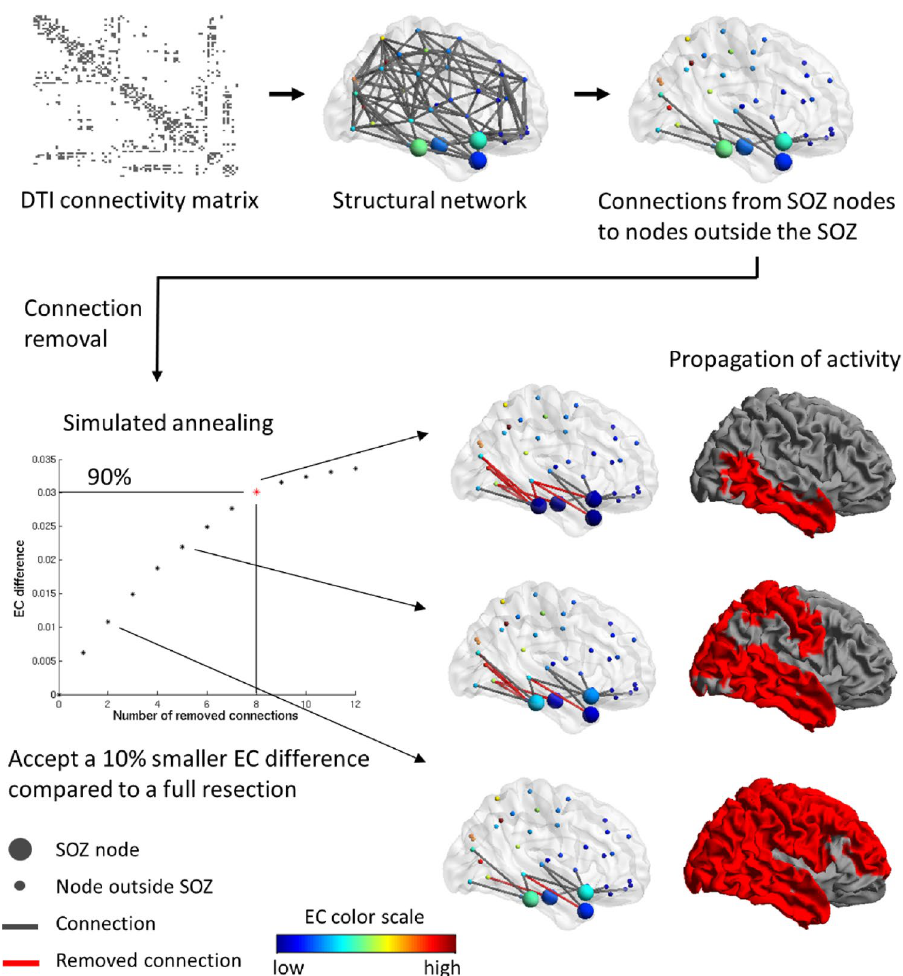
Figure 2. Workflow of selecting the connections to remove for each patient. The patient’s DTI connectivity matrix of white matter tract density between 92 ROIs is thresholded and binarized to a connectivity density of 11%. This connectivity matrix is the basis for the structural network. Subsequently, the connections from SOZ nodes to nodes outside the SOZ are identified—they were all severed in the surgery. Those connections are candidates for the virtual resection in our model. For each number of removed connections, the optimal choice of connections is found using simulated annealing. Simulated annealing optimizes for those connections that upon removal result in the largest EC difference of the SOZ. After the maximal achievable EC difference has been found for each number of removed connections, the number of connections yielding 90% of the EC difference compared to the maximum (when removing all connections) is found and removed. Because removing the first few connections has a larger effect than removing further connections, a relatively large number of connections can be spared yet still achieving an almost maximal effect. The rationale behind the method is illustrated with the propagation of activity (red brain regions indicate active regions at the same time after seizure onset): removing the connections that decrease the EC of the SOZ results in a decrease in speed with which activity propagates. Parts of the figure were visualized with the BrainNet Viewer toolbox (Xia et